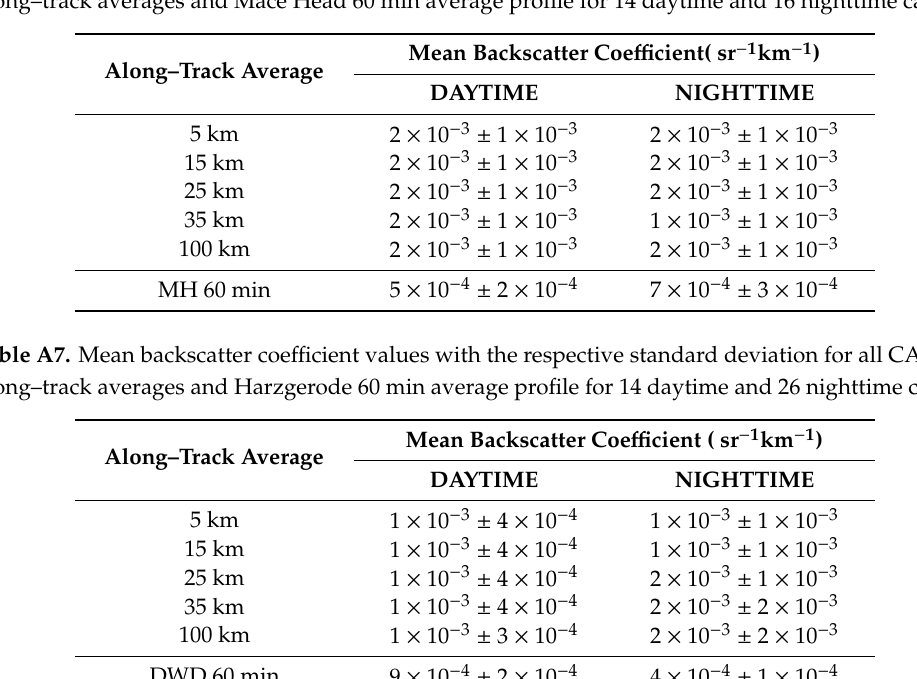
Table A6. Mean backscatter coe ffi cient values with the respective standard deviation for all CALIOP along–track averages and Mace Head 60 min average profile for 14 daytime and 16 nighttime cases.